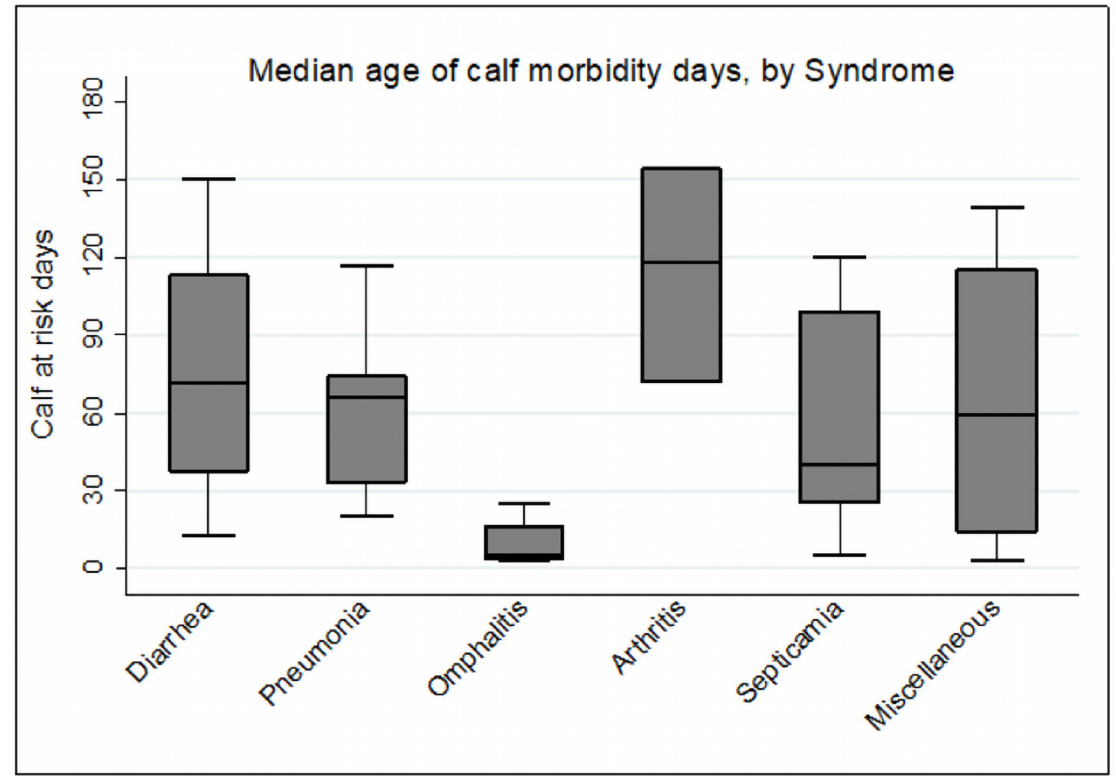
Fig 2. The description of the median age of morbidity by syndromes.